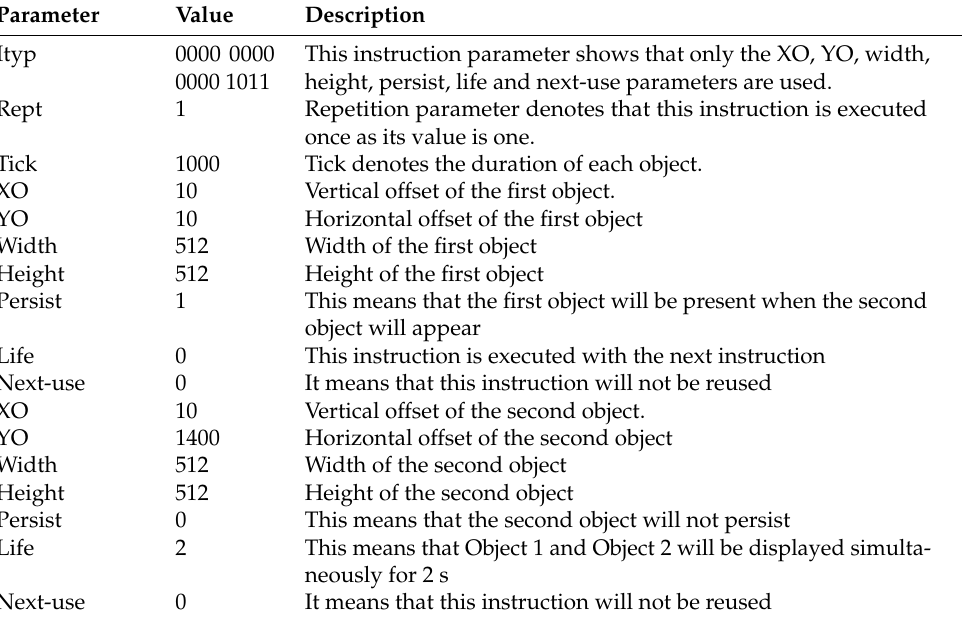
Table A13. Values of the INST parameters for the fourth example.